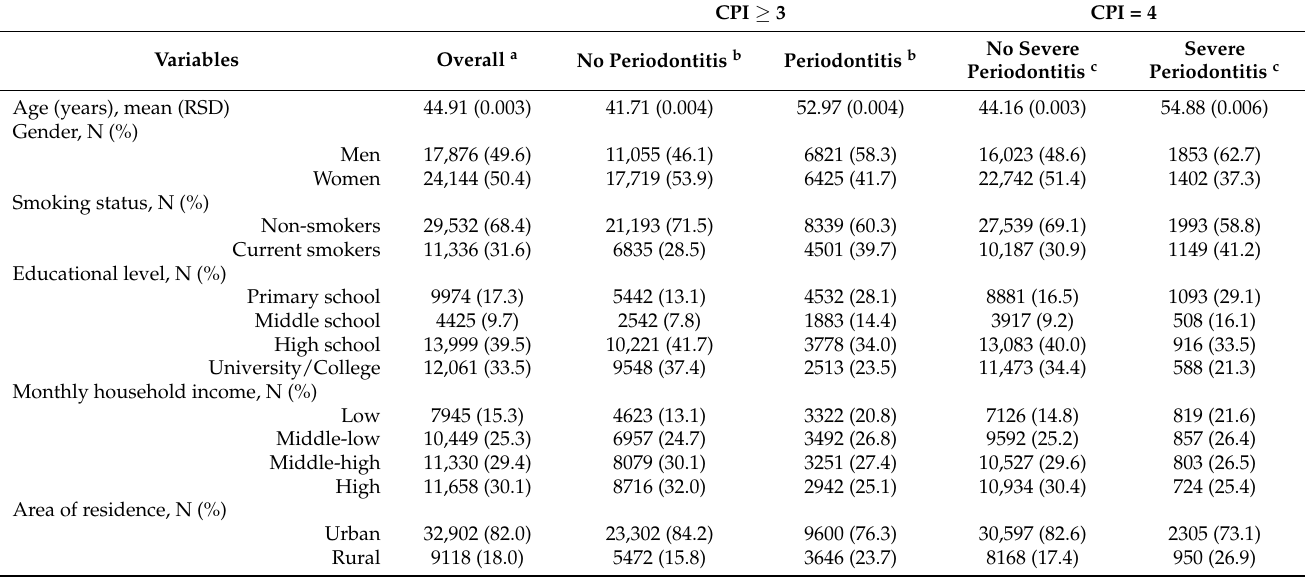
Table 1. Characteristics of the study population and air pollution factors, overall and by periodontal